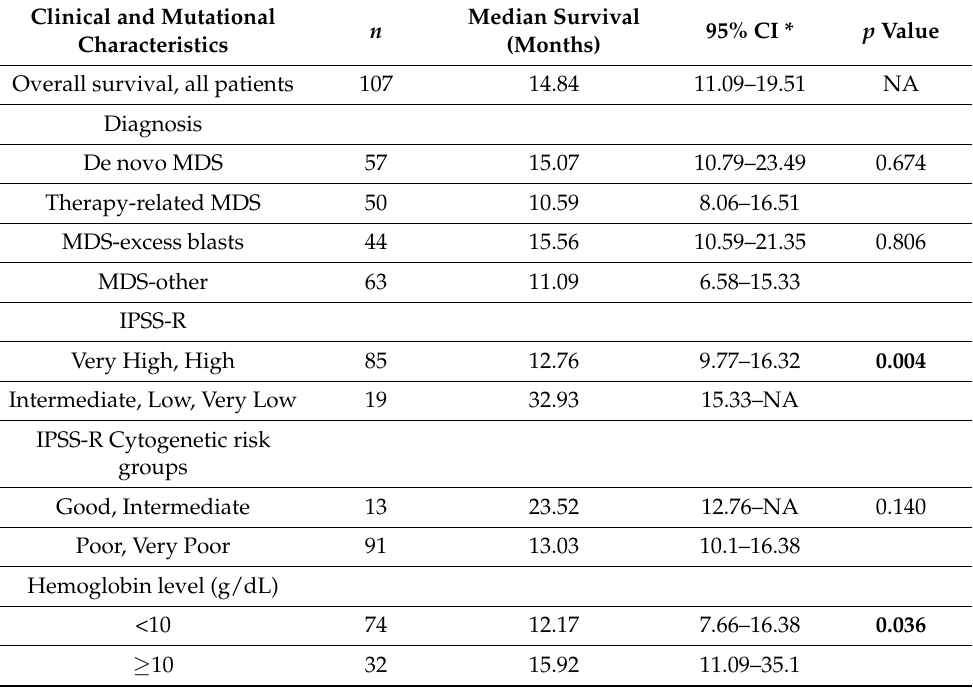
Table 3. Association of clinical and mutational characteristics with prognosis. Clinical and